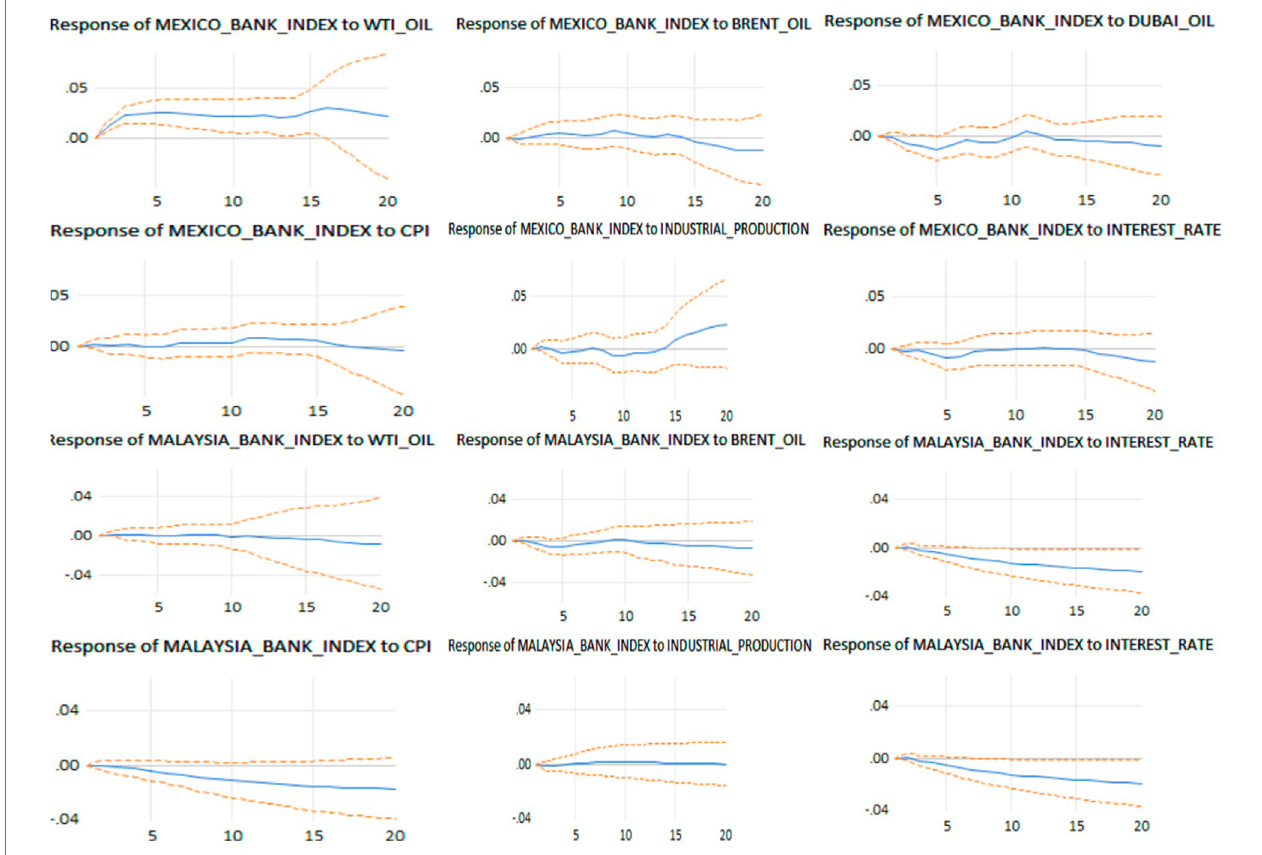
FIGURE 3 | Impulse response function analysis: Mexico, Malaysia.